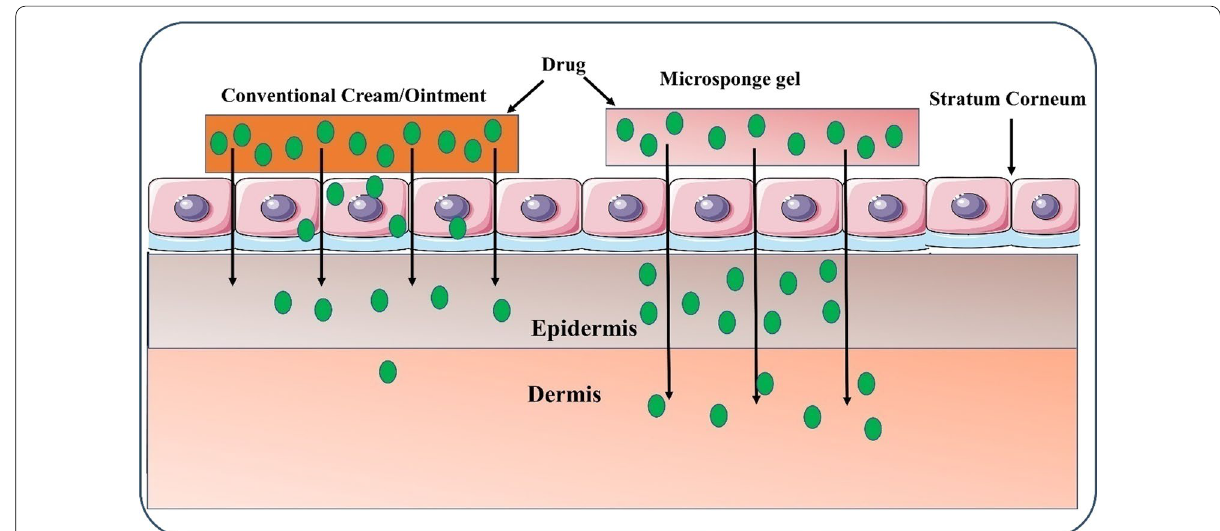
Fig. 1 Penetration of microsponge of loaded material (active) through